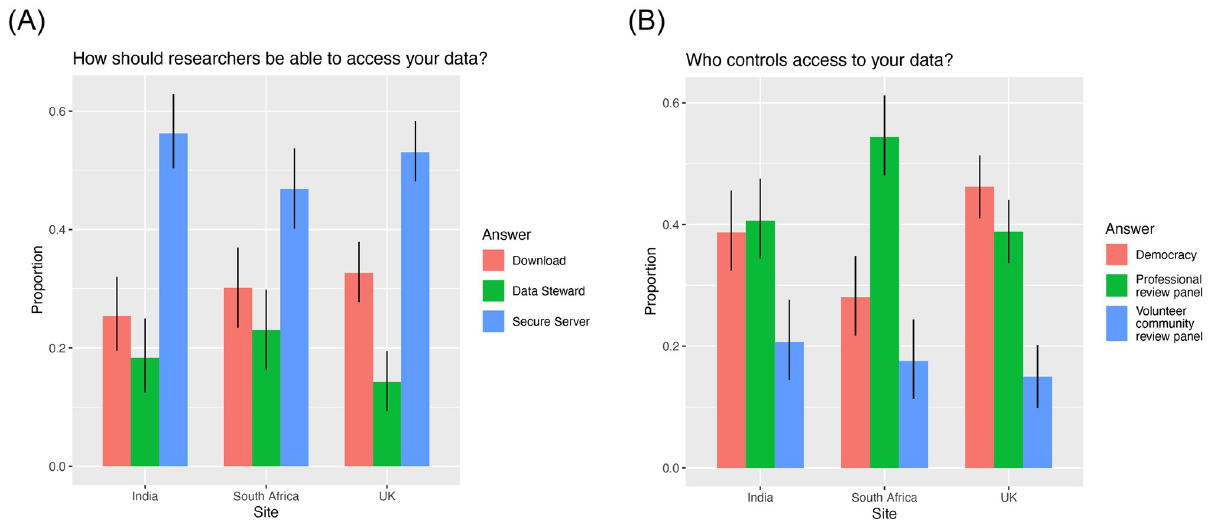
Fig 4. Participant choice for (A) “ Who controls access to your data ? ” and (B) “ How should researchers access your data ? ” grouped by country for participants randomized to Group